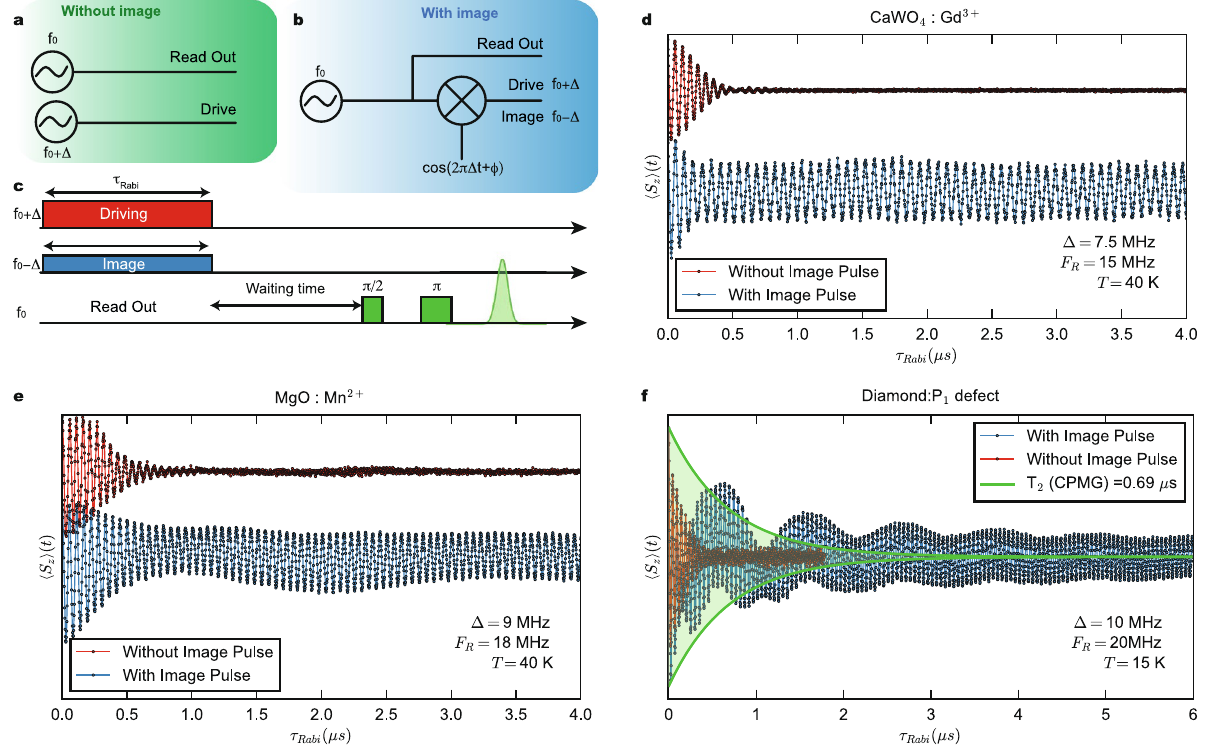
Figure 1. Comparison of Rabi oscillation with or without the image pulse. ( a – c ), Schematic of the microwave (cid:31) ) and the readout ( f 0 ) sources are independent. ( b ) Using the same source implementation. ( a ) The drive ( f + (cid:31) ) is generated by a non-linear mixing with a low frequency signal as the readout ( f 0 ), the drive pulse ( f 0 − (cid:31) , with f 0